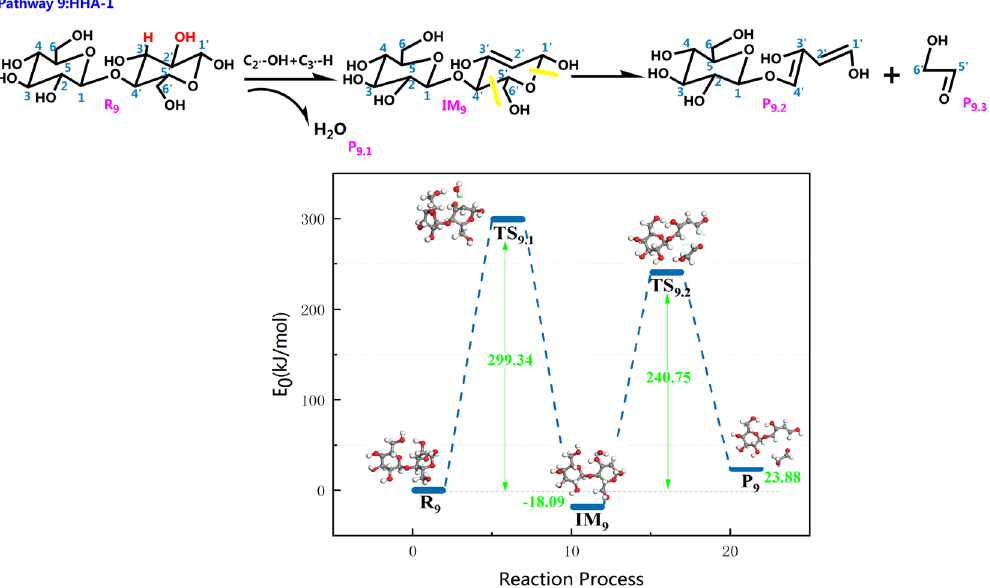
Figure 14. Reaction step and reaction energy barrier of pathway 9.